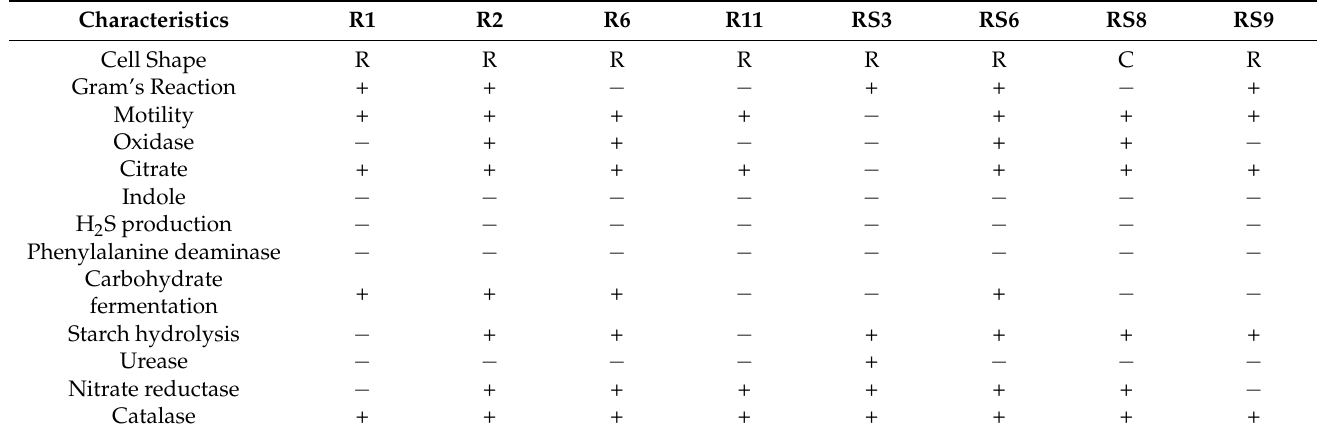
Table 1. Biochemical characterization of endophytic bacterial strain (+ve =Positive, − ve = Negative activity). Characteristics R1